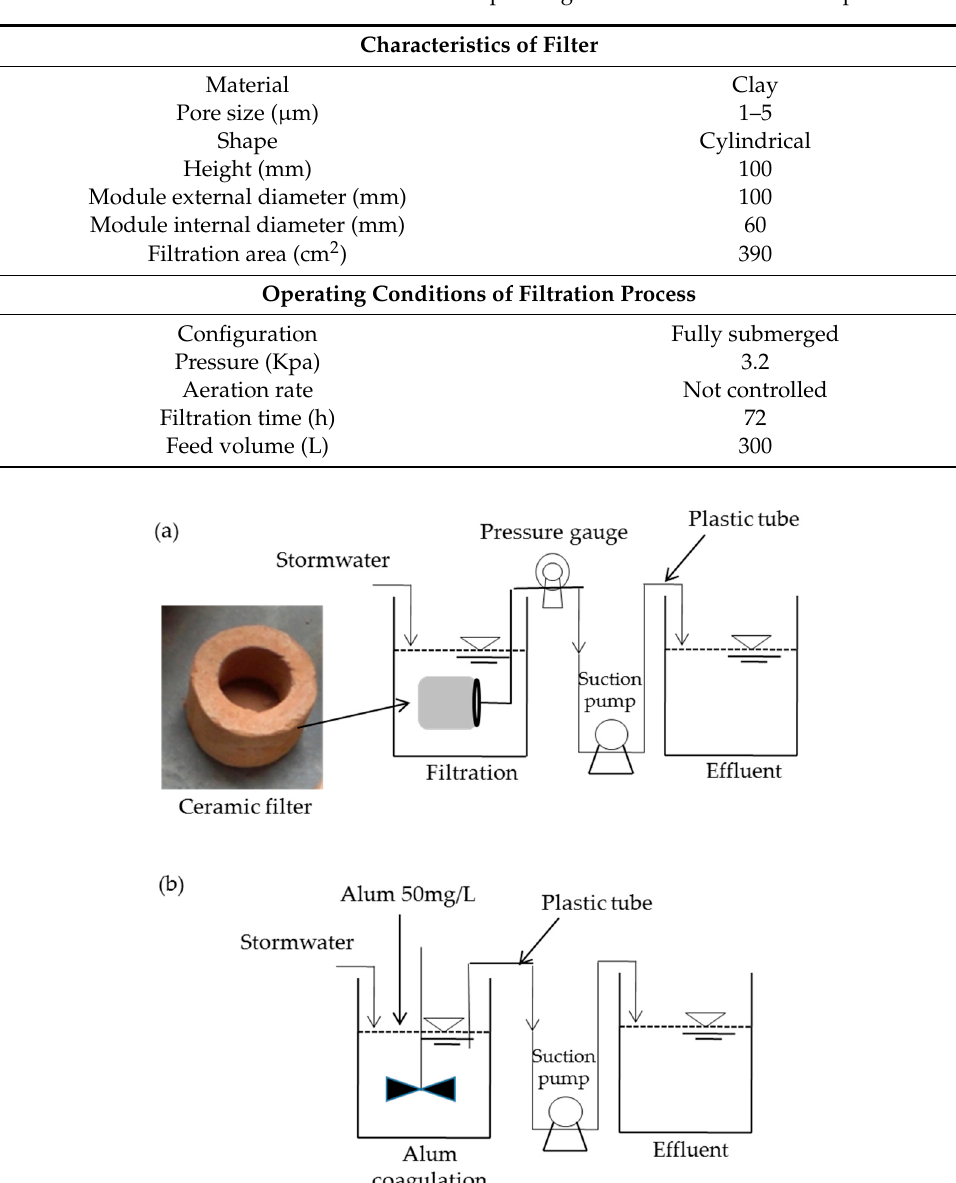
Table 1. Characteristics of ceramic filter and operating conditions of the filtration process.